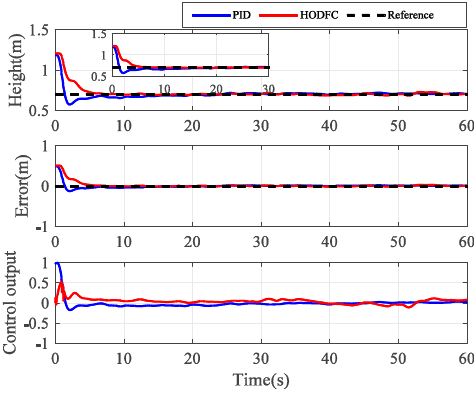
Figure 8. Experimental results with a fixed height of 0.7 m.